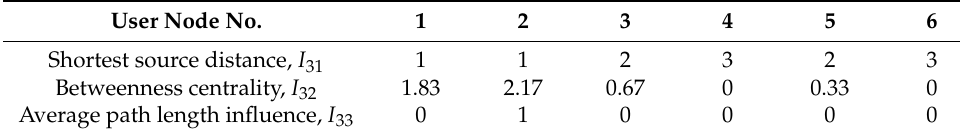
Average path length influence, I